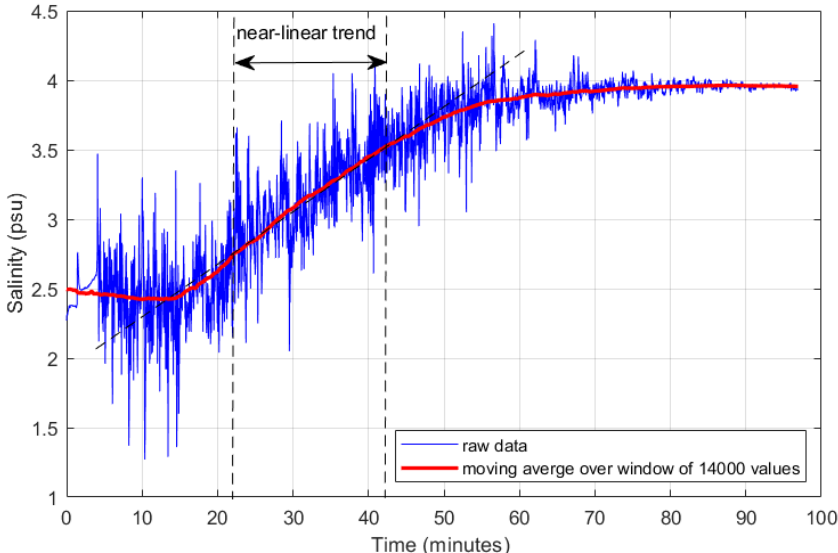
Figure 14. The salinity (blue line) as derived from the conductivity data registered by the microsensor of electrical conductivity with a frequency of 10 Hz in the density interface layer. Red line indicates moving average of the salinity. The vertical dashed bars indicate the data ensemble used for the spectral analysis.